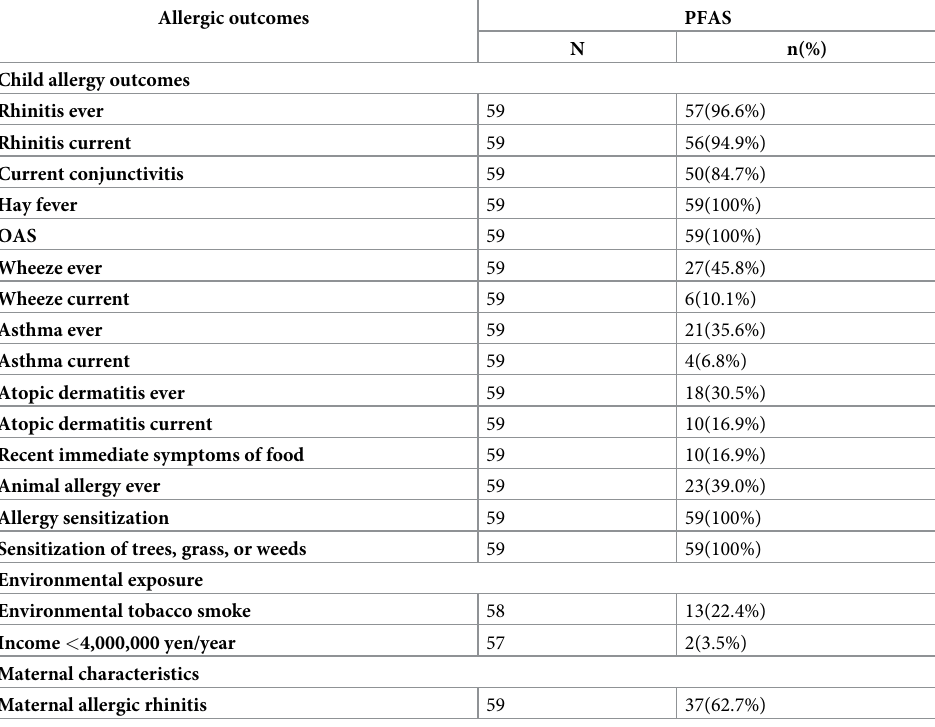
Table 6. Characteristics of allergic outcomes of PFAS adolescents at 13 years